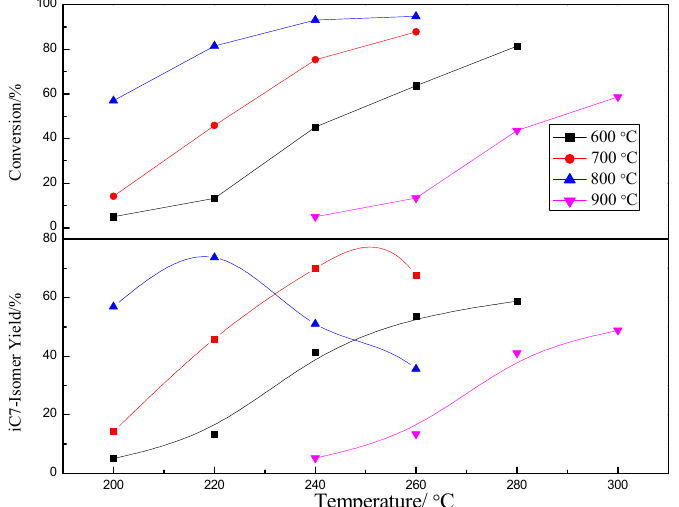
Figure 10. Activities of the Cr-Pt/WZ catalysts calcined at 600~800 °C. Reaction condition: n(H 2 ):n(C 7 ) = 5 mol L/mol, LHSV = 0.7 h − 1 , and P = 1.0 MPa, T = 200–300 °C.